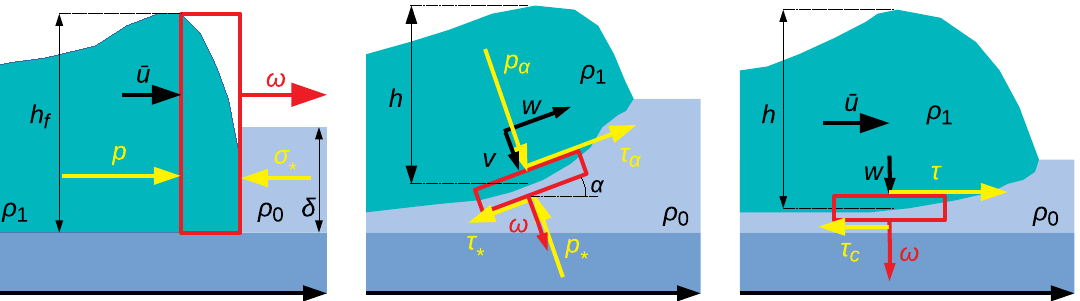
Figure 3. Control volumes used in the derivation of the Eglit–Grigorian (EGYEM, left), Grigorian– Ostroumov (GOEM, middle), and tangential-jump (TJEM, right) entrainment models. Note that the EGYEM and GOEM evaluate the jump equations for the velocity and momentum components normal to the “long” side of the control volume while the TJEM considers tangential velocity and shear